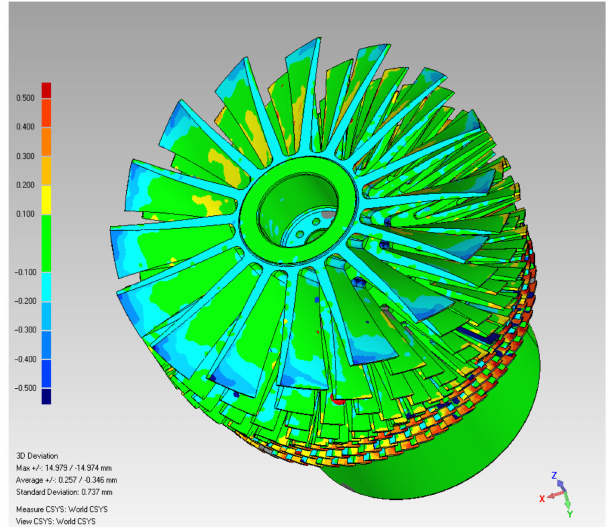
Figure 6. Error comparison